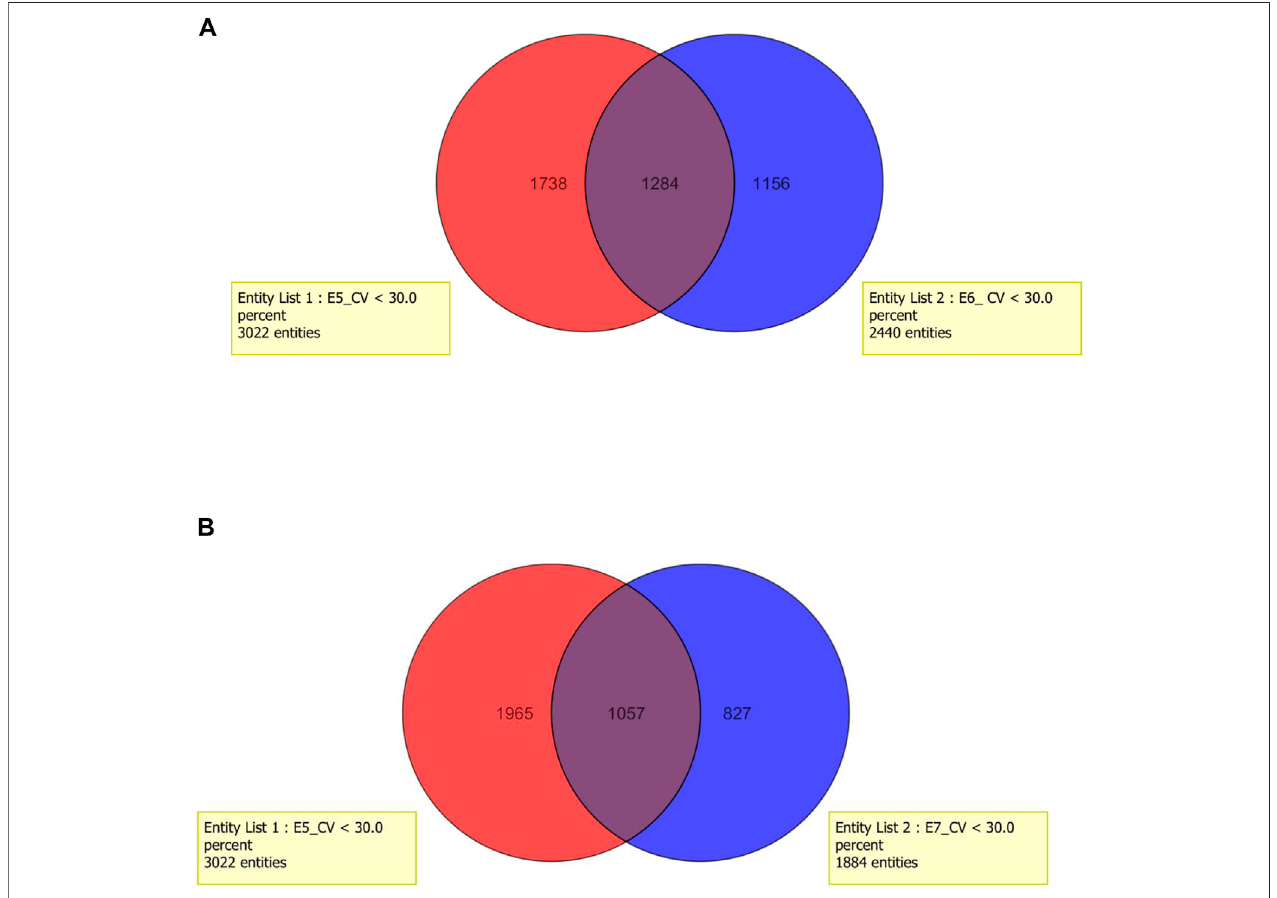
FIGURE 4 | Venn diagram for two tested factors: (A) time of incubation within deproteinization process and (B) volume of extraction mixture.